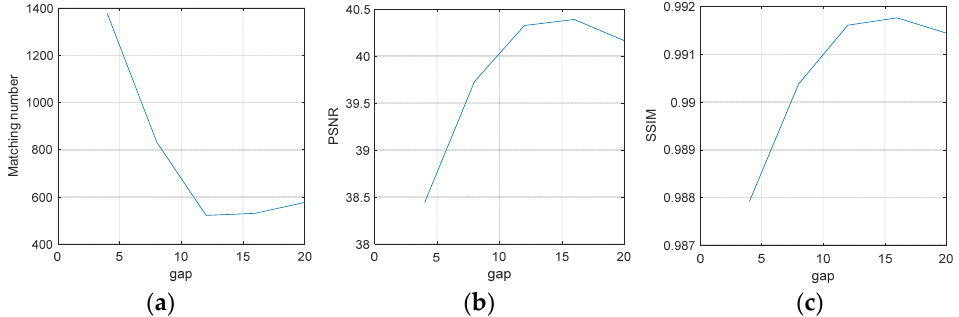
Figure 7. The effects of a traversal gap on batch modification: ( a ) Matching number; ( b ) PSNR; ( c ) SSIM.